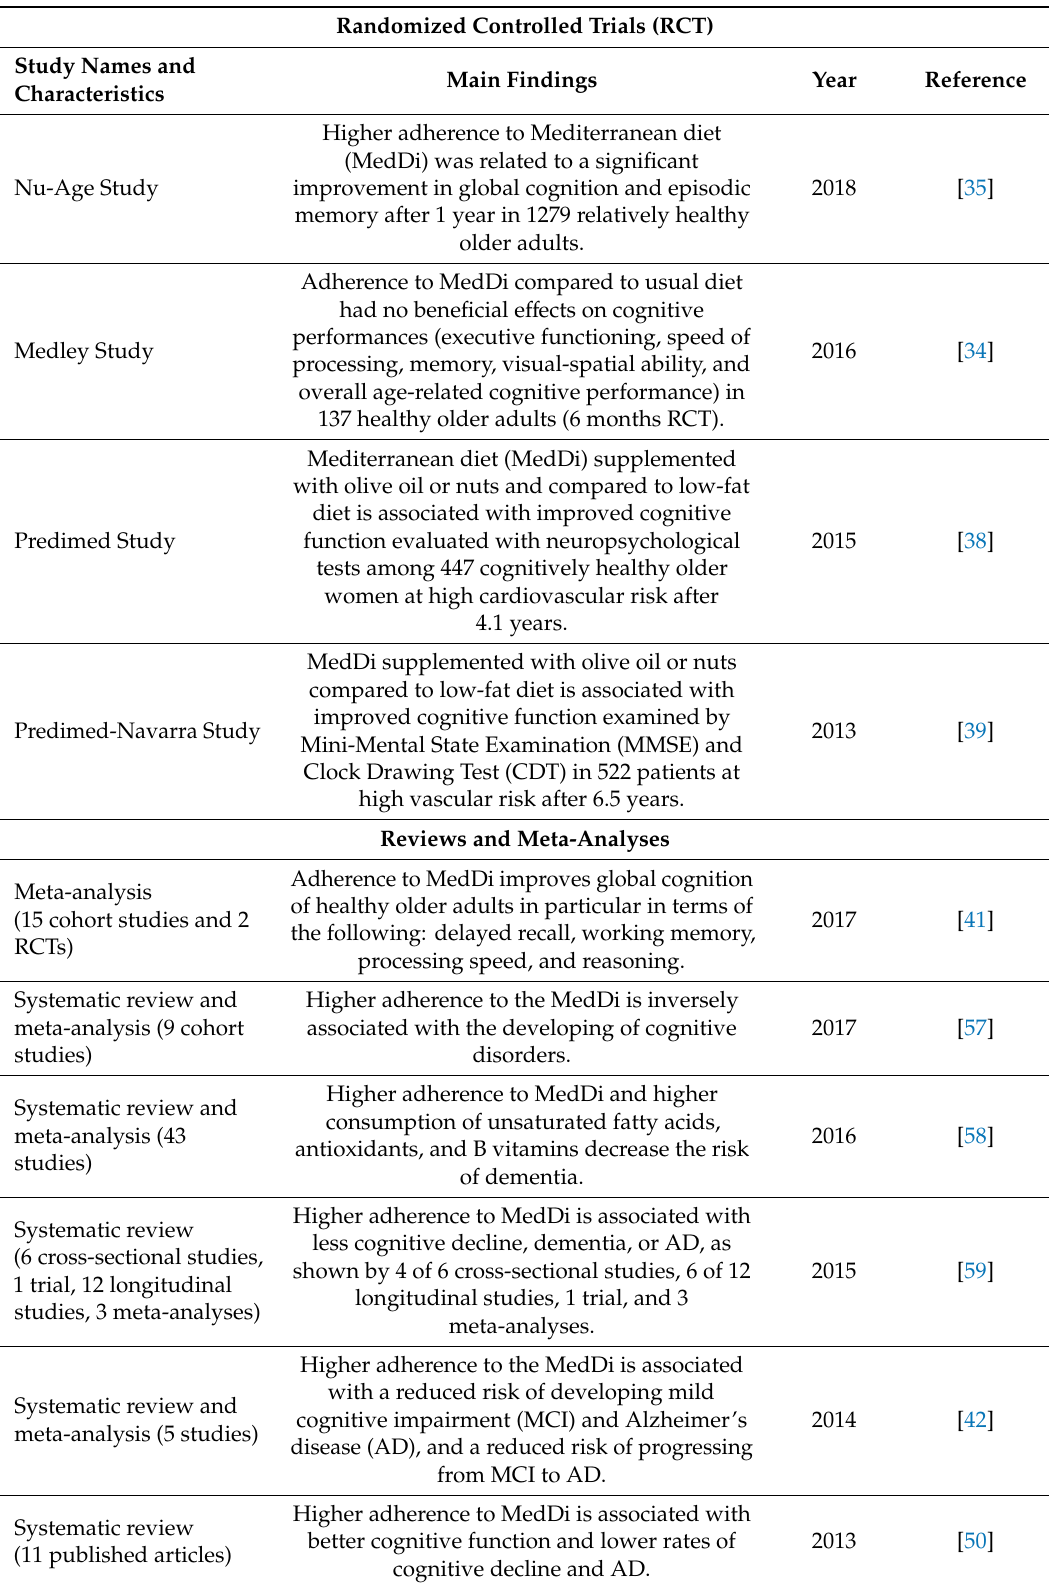
Table 2. Evidence on association between Mediterranean diet and cognitive decline. Randomized Controlled Trials